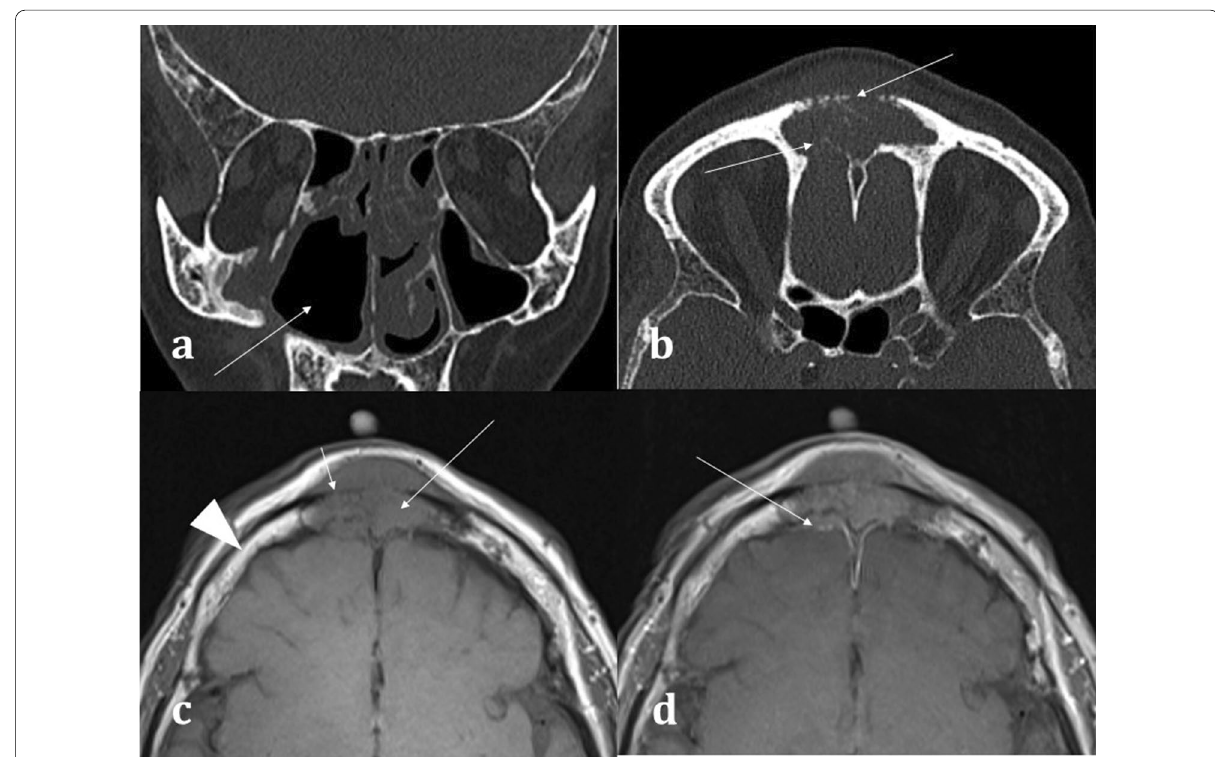
Fig. 6 Transpatial spread of recurrent of sinonasal squamous cell carcinoma (SCC), in the same patient as shown in Fig. 4b. Coronal bone window CT a demonstrates the right maxillectomy. Axial bone window CT b shows a permeative process within the frontal sinus causing cortical destruction (arrowed). T1WI demonstrates recurrent SCC involving the frontal sinus ( c ), expanding the sinus and infiltrating the bone (long arrow) with loss of the normal fatty marrow signal (arrowhead for comparison). There is clear evidence of inner and outer table cortical breach on T1WI with loss of the normal hypointense cortical rim (short arrow) placing the patient at risk of intracranial disease. The lesion demonstrates mild enhancement ( d ), with associated dural thickening and enhancement (arrow) indicating transpatial spread